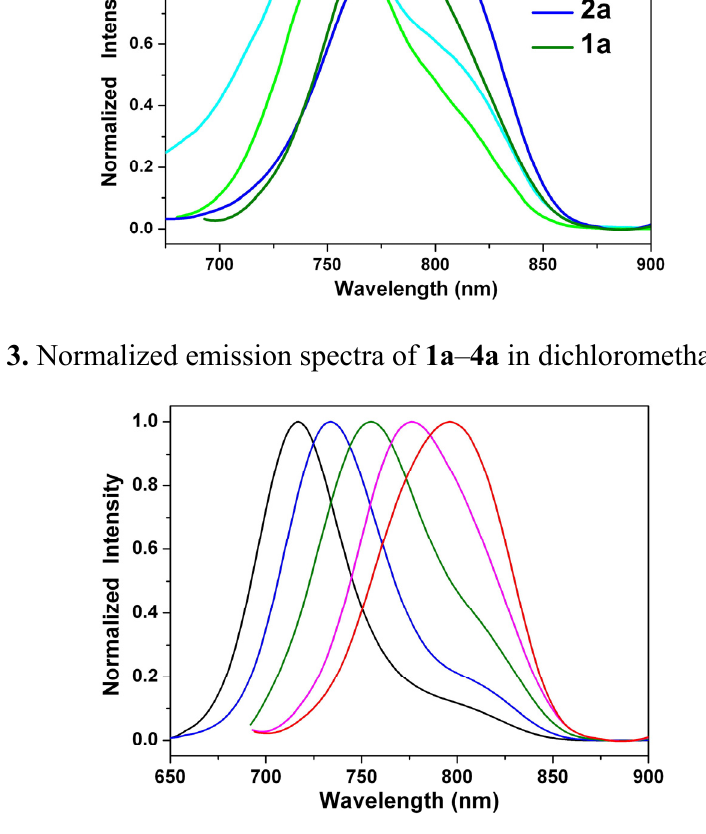
Figure 4. Normalized emission spectra of 1a in cyclohexane (black line), diethyl ether (blue line), ethyl acetate (olive line), dichloromethane (pink line), and acetonitrile (red